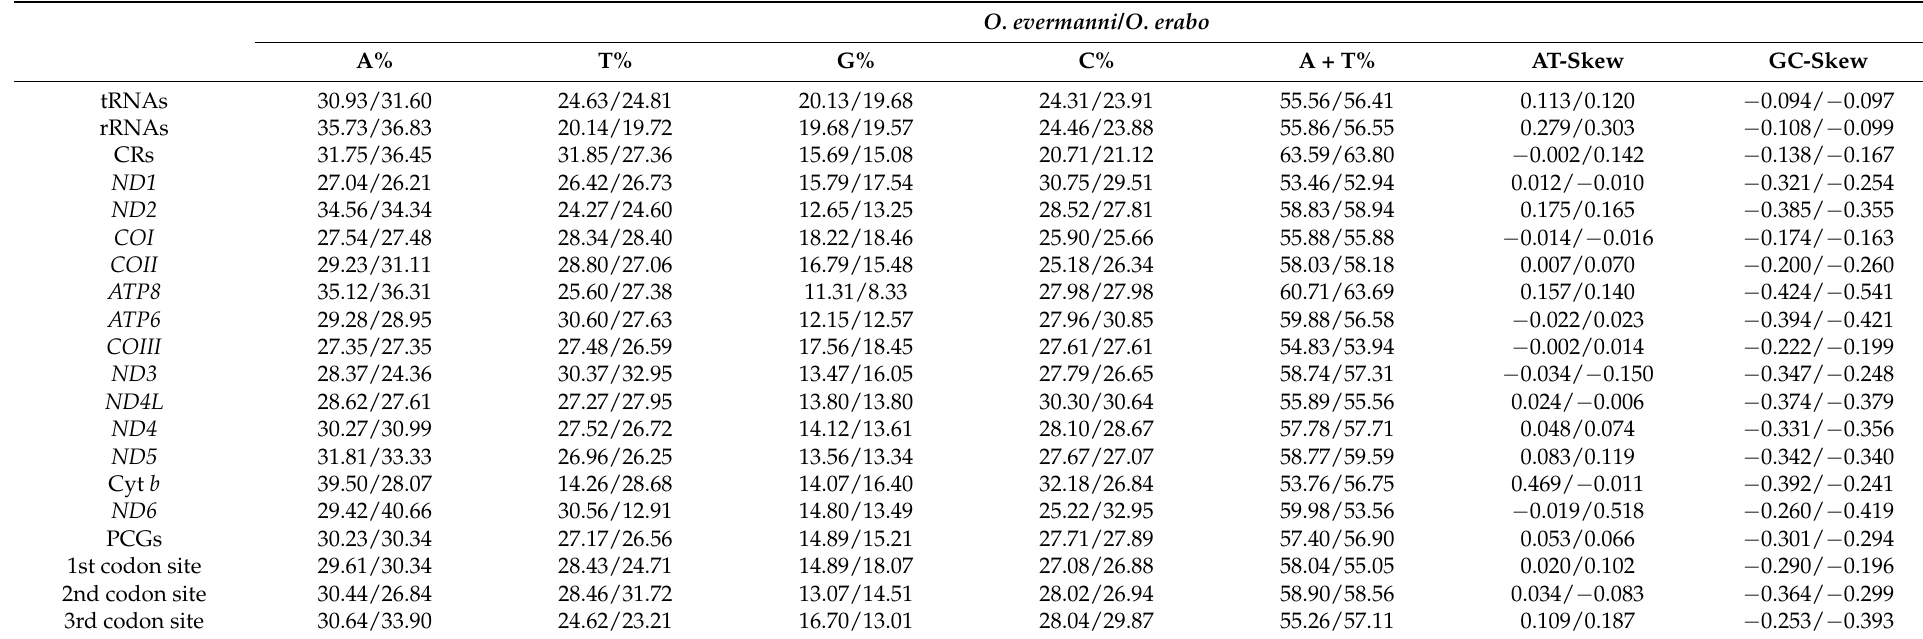
Table 2. Composition and skewness of mitogenomes in two Ophichthus